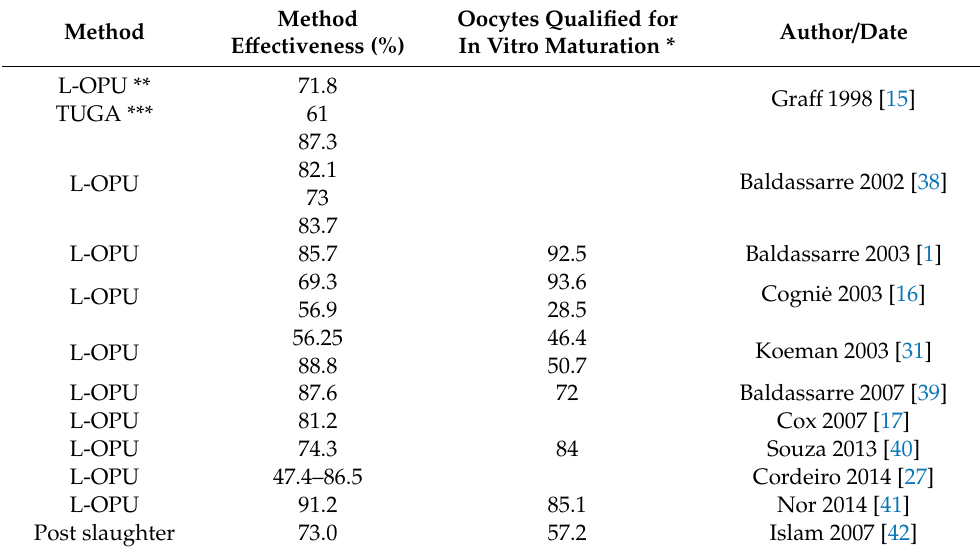
Table 3. Comparison of e ff ectiveness of oocyte recovery using the ovum pick-up method in